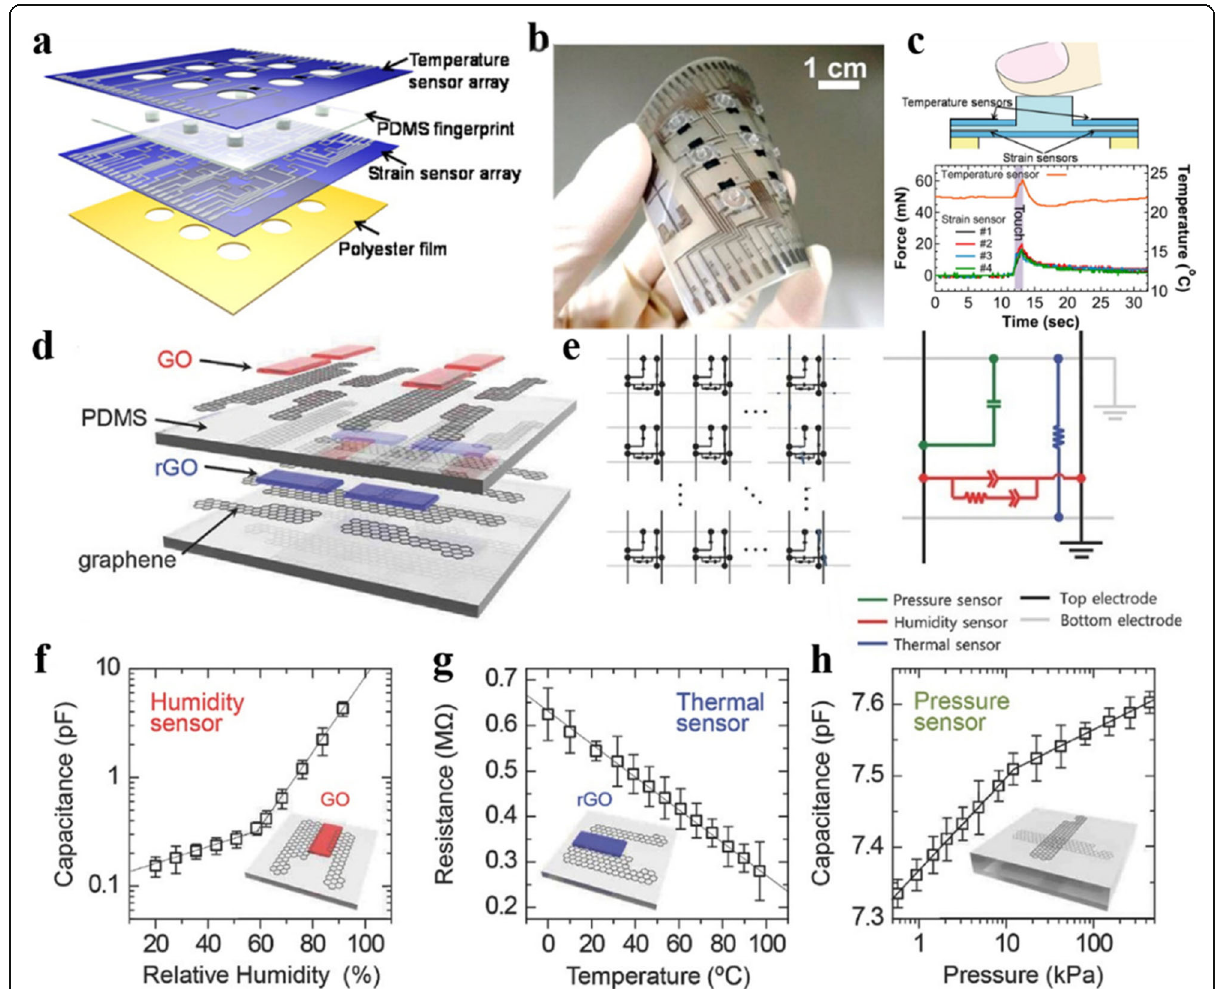
Fig. 10 a Schematic for the structure of multilayer sensor. b Picture of a 3 × 3 sensor array. c schematic and measurement results of the multifunctional sensor when touching a fingerprint-like structure with a human finger. Adapted with permission from ref. 4. Copyright 2014 American Chemical Society. d Schematic diagram of the multimodal e-skin sensor. e Circuit diagram of the sensor matrix. f Performance of the humidity sensor based on GO. g Performance of the temperature sensor based on rGO. h Performance of the pressure sensor based on PDMS. Adapted with permission from ref. 55. Copyright 2016 John Wiley and